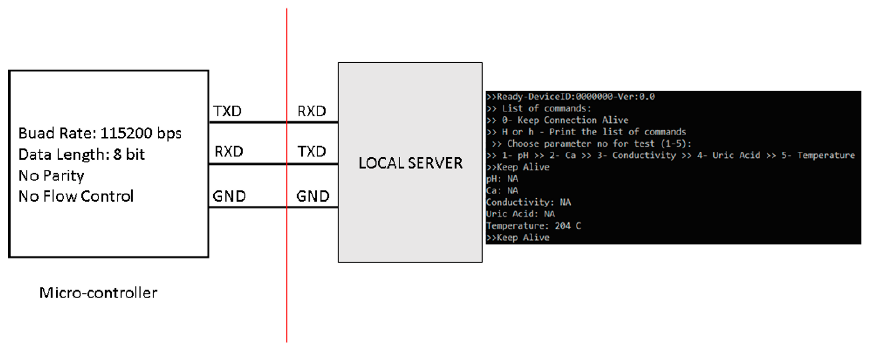
Figure 10. Digital system communication with the local server.